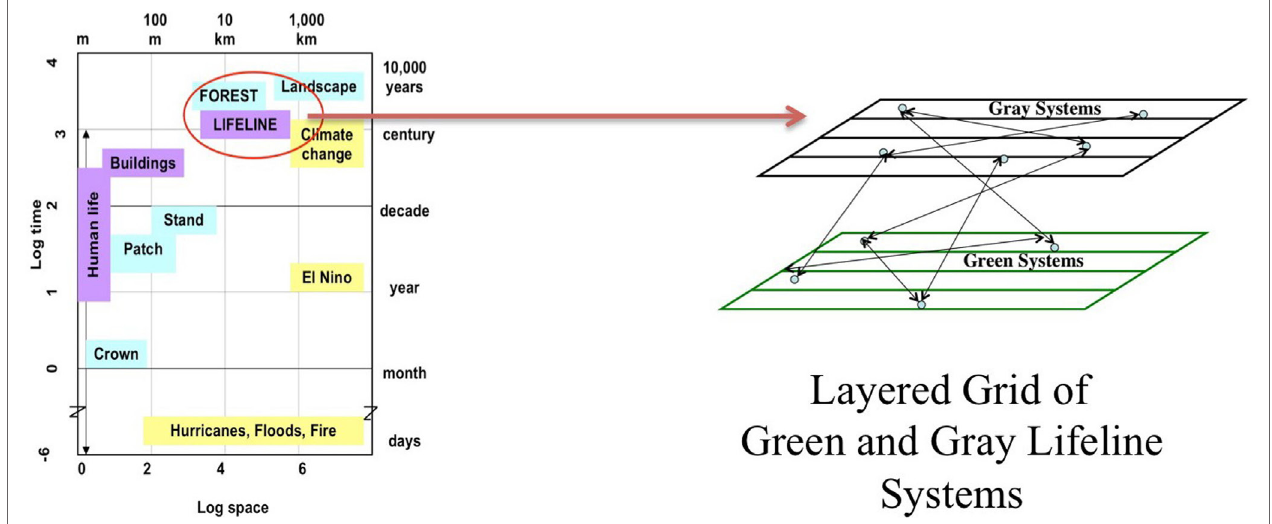
FigUre 1 | Space and time scales for green and gray infrastructure systems, after Gunderson and Holling (2002).